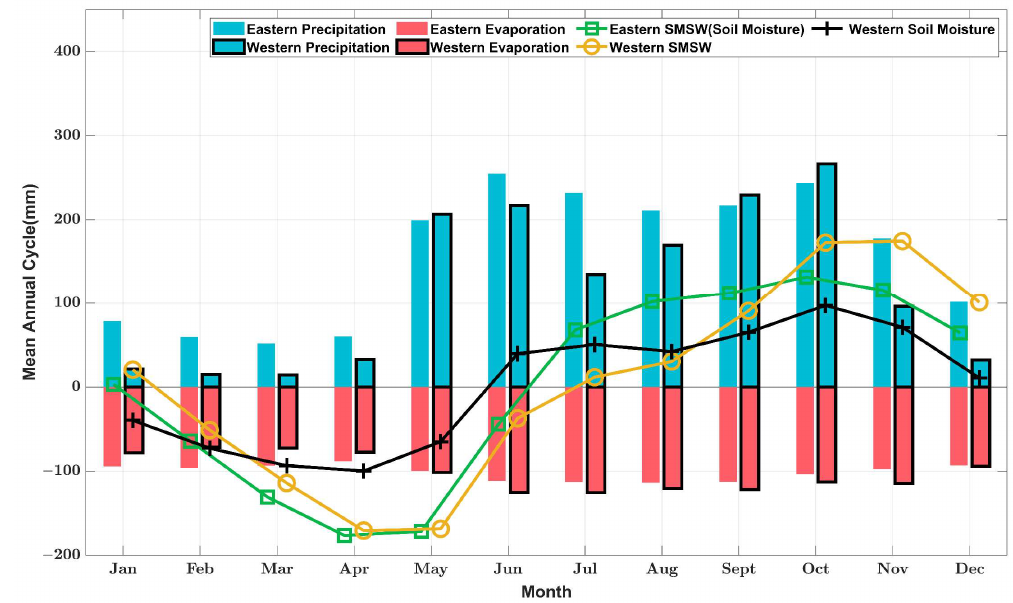
Figure 7. The mean annual cycle of precipitation, evaporation, SMSW, and soil moisture in western and eastern Nicaragua, respectively. Soil moisture and SMSW are equivalent in eastern Nicaragua, so they use the same notation. To better visualize the results, we multiplied the evaporation by − 1.